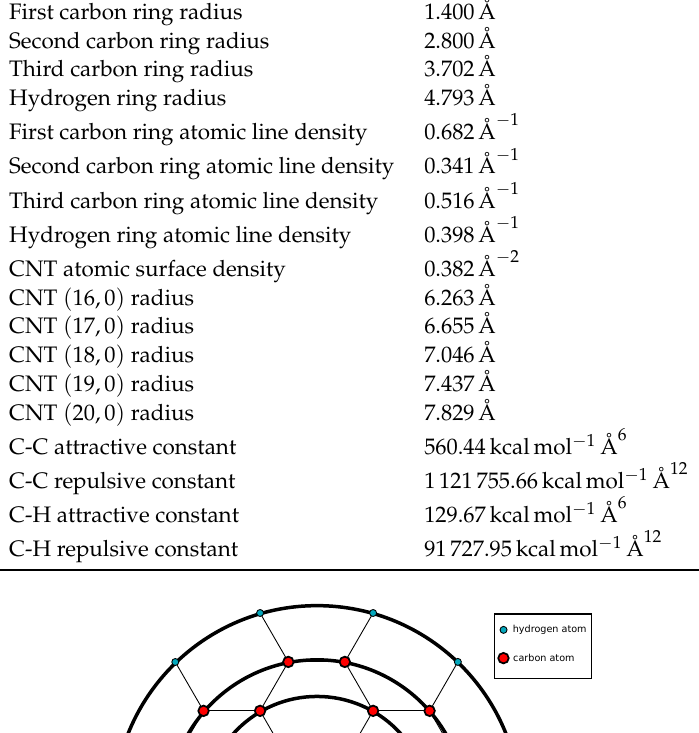
Table 1. Numerical values of constants used in present model.